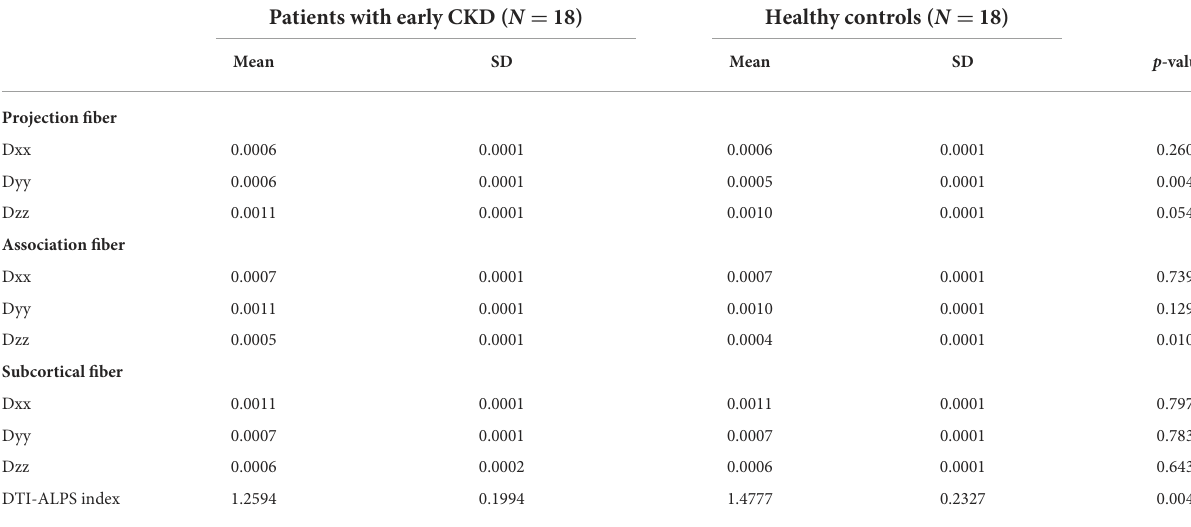
TABLE 2 The differences of the diffusivities along the axis in the fibers between patients with early CKD and healthy controls. Patients with early CKD ( N = 18) Healthy controls ( N = 18) Mean SD Mean SD p